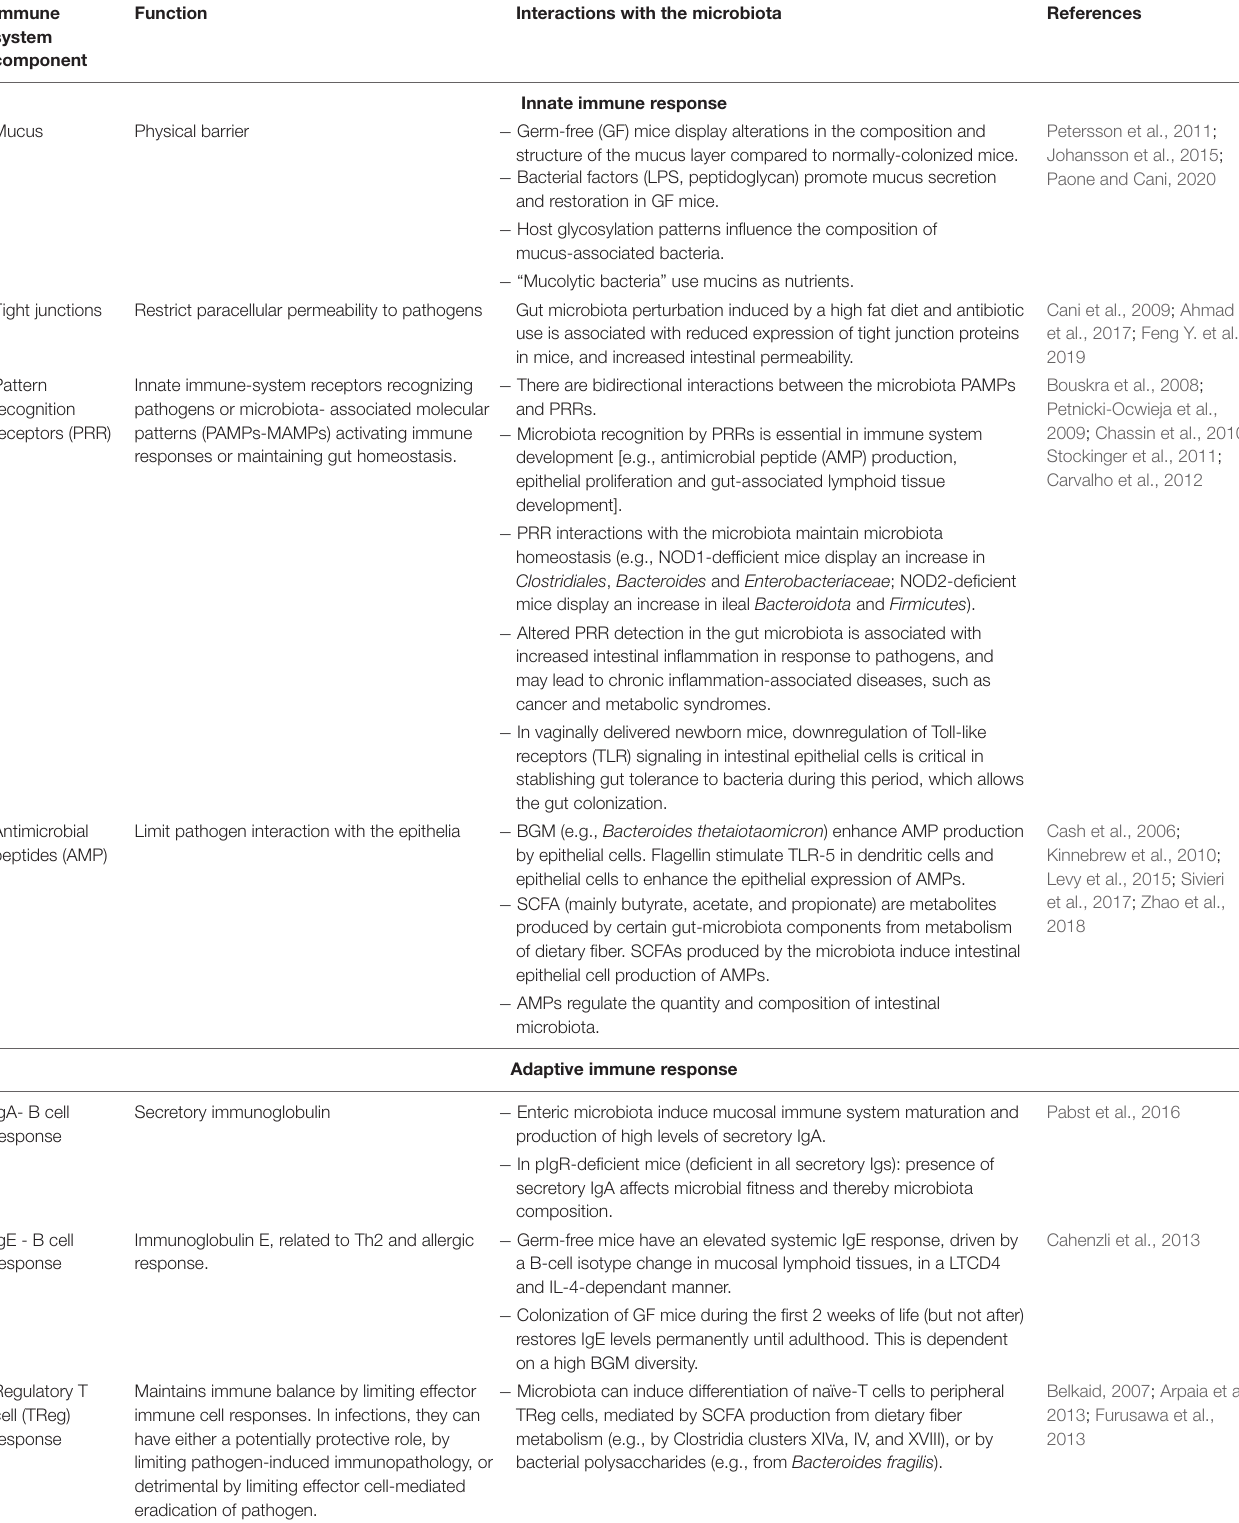
TABLE 3 | Recognized interactions between the immune system and the gut